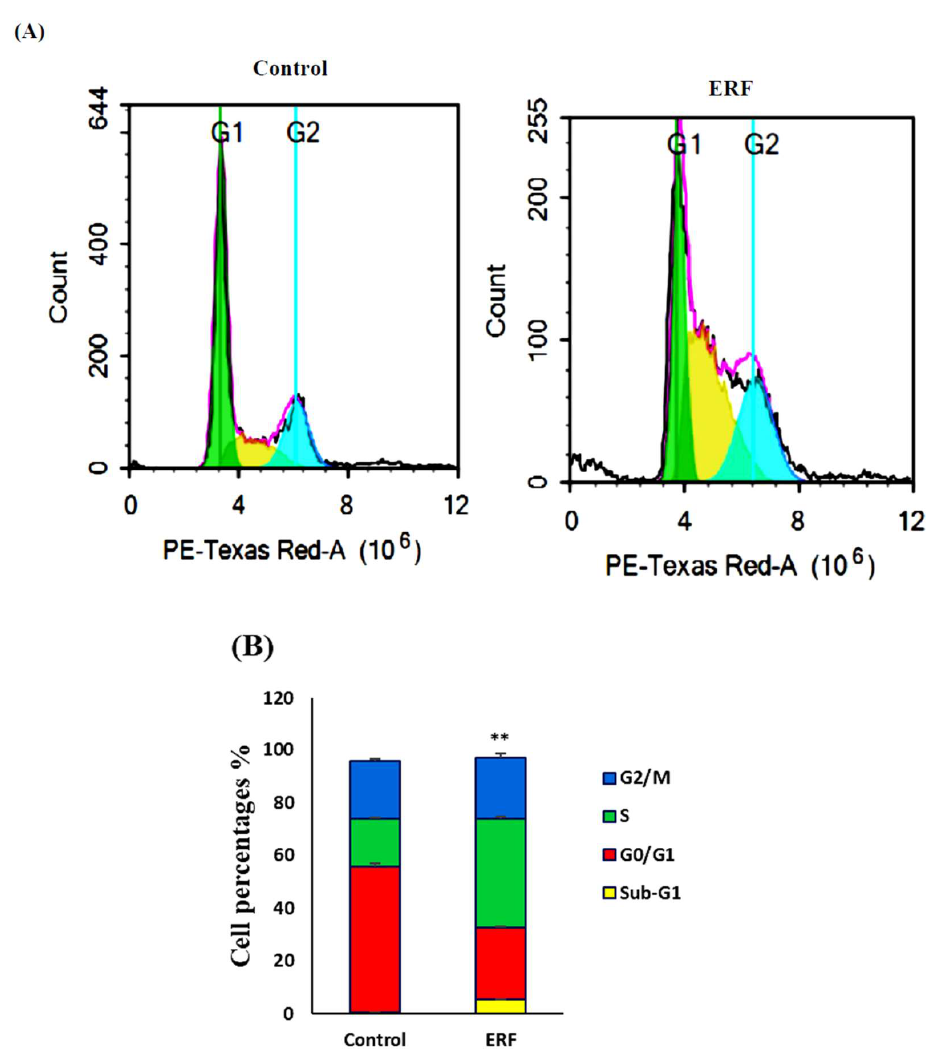
Figure 8. Representative flow cytometry analysis of HepG2 cells treated for 48 h with the IC 50 of the ERF. DNA cytometry analysis was performed to examine cell cycle distribution, and diverse cell phases ( A ) were plotted as percentages of total occurrences ( B ). ** Significantly different from the control group; results are provided as mean ± SD; n =